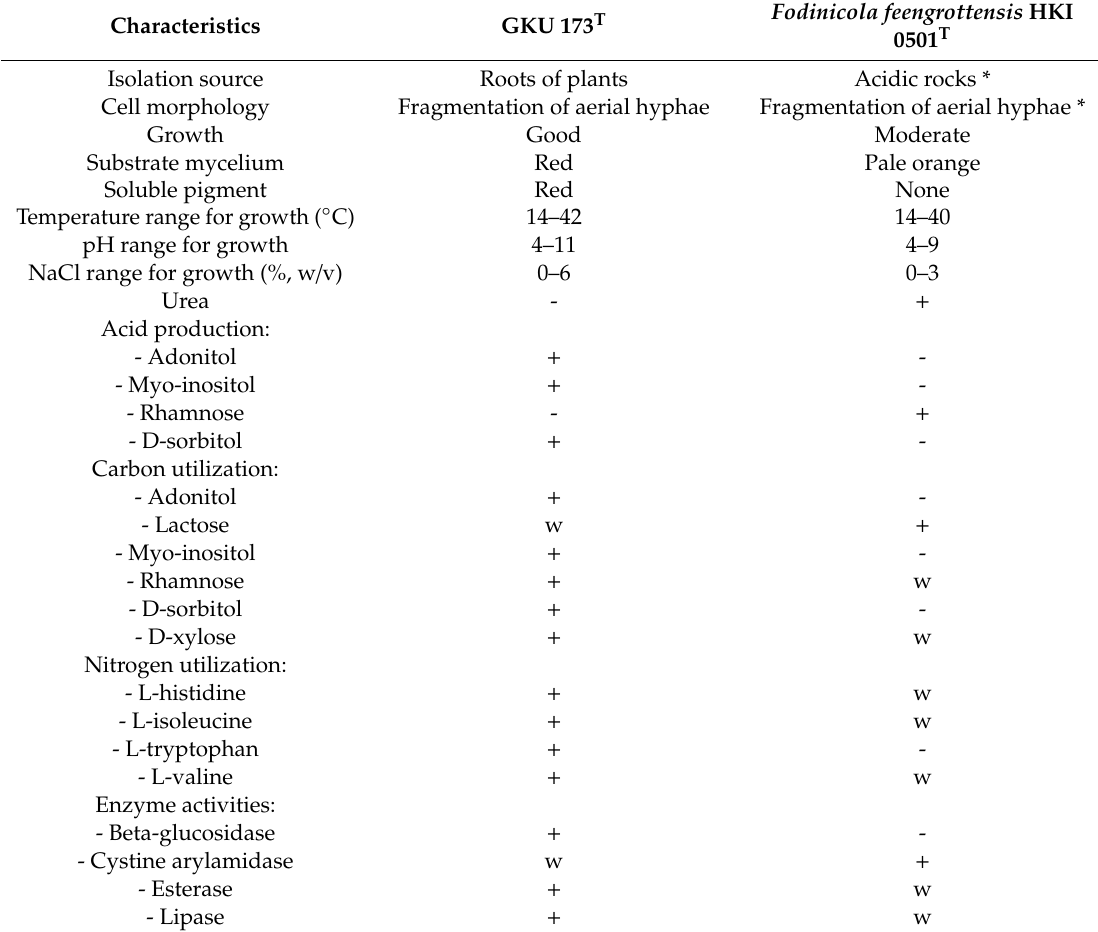
Table 1. Di ff erential characteristics of strain GKU 173 T and closely related Fodinicola species. All data obtained from the present study unless otherwise indicated. + , Positive; w, weakly positive; -,